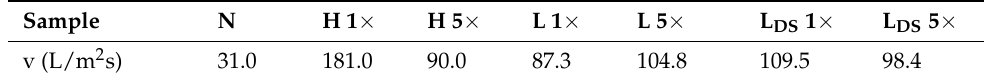
Table 5. Air permeability of medical masks before and after